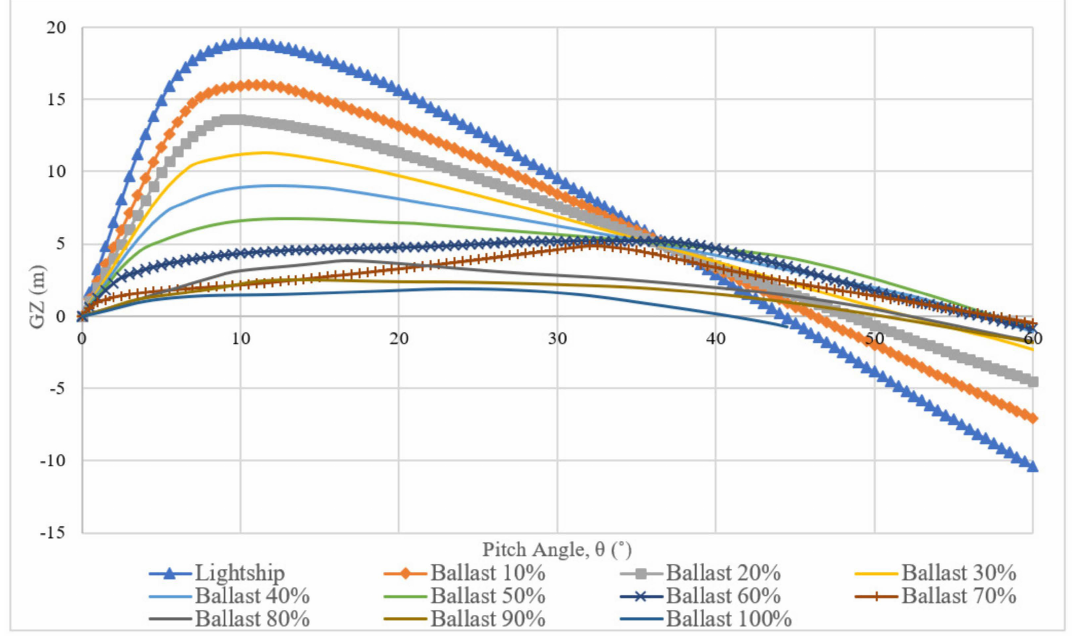
Figure 8. GZ curves for